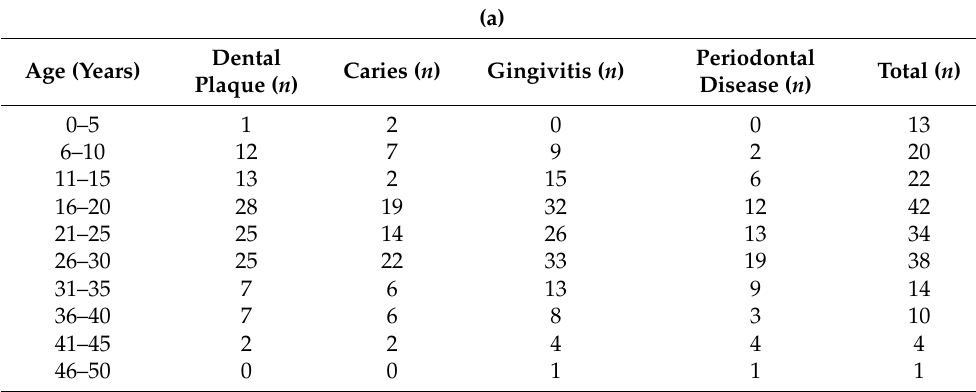
Table 2. ( a ) Clinical Characteristics of the Study Group with Down syndrome. ( b ) Clinical Character- istics of the non-syndromic Control